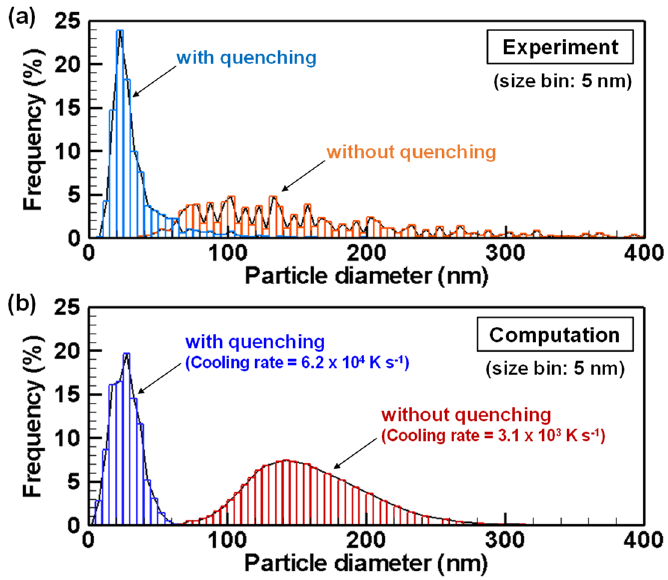
Figure 5. Size distributions of silicon nanoparticles obtained from ( a ) experiments and ( b ) computations.